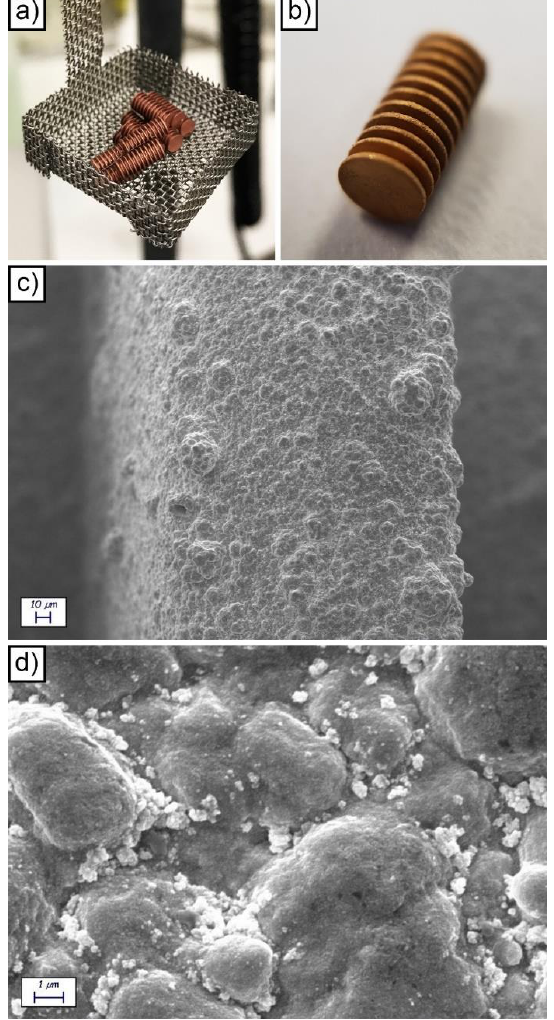
Figure 2. Visual appearance of the barrel setup used to metallize the devices ( a ); visual appearance of a Cu/CoNiP/Au coated device ( b ); SEM images of a metallized device observed at 1000 X ( c ) and 20 , 000 X ( d ).